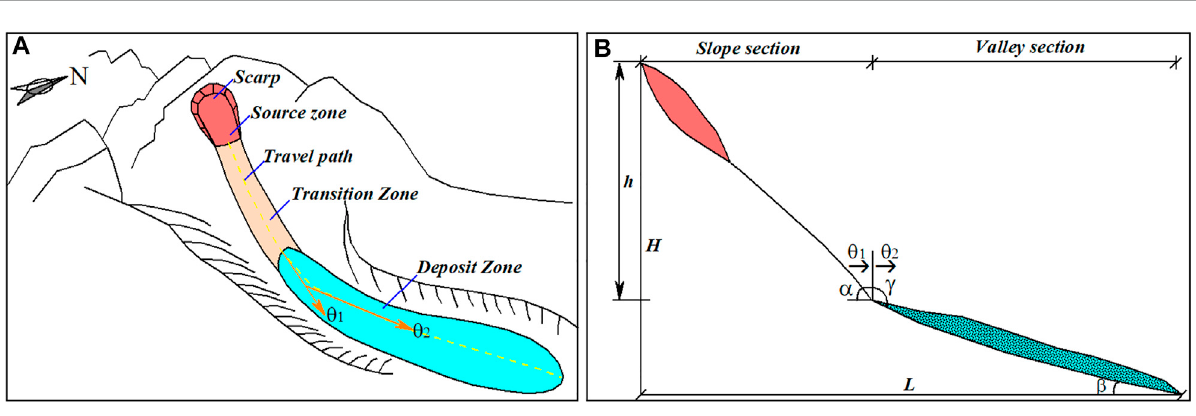
FIGURE 1 (A) Plane sketch of the de fl ected-type rock avalanches ( θ 1 is refers to the initial motion direction of the rock avalanches, and θ 2 is refers to the valleyextensiondirection); (B) Schematicdiagramoflocaltopographylongitudinalsectionalongthedirectionofmotionpathshowingthemainlocal topographic parameters of thede fl ection-typerock avalanches consist of theslope angle ( α ),channelangle ( β ), slope height ( h ),de fl ectionangle ( θ ), slope transition angle ( γ ) and fall height ( H